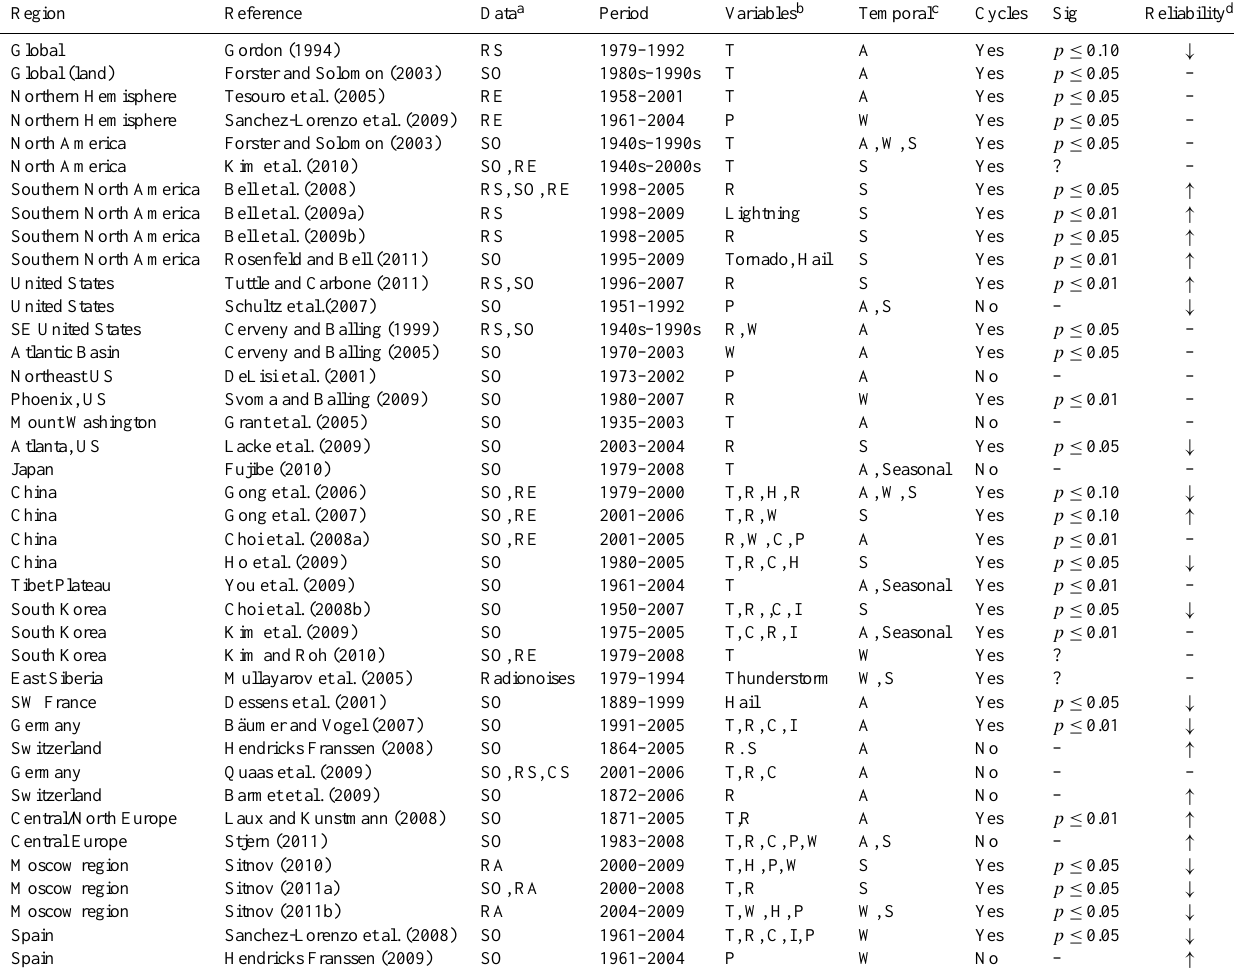
Table 1. Summary of the reviewed studies, including information regarding the region studied, the type of data, period, variables and temporal resolution. If significant WCs are reported, also the statistical level of confidence is given (if provided by author(s)), as well as the reliability of the statistical analysis used in the